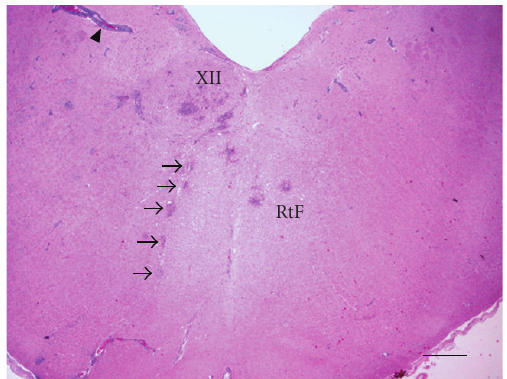
Figure 1: Cow with rhombencephalitis due to Listeria monocyto- genes infection. The cow has problems with swallowing (note the feed below her head) and shows increased salivation, facial paralysis with drooping of left ear and upper eyelid, courtesy of Dr. Mireille Meylan, Vetsuisse Faculty, University of Bern.